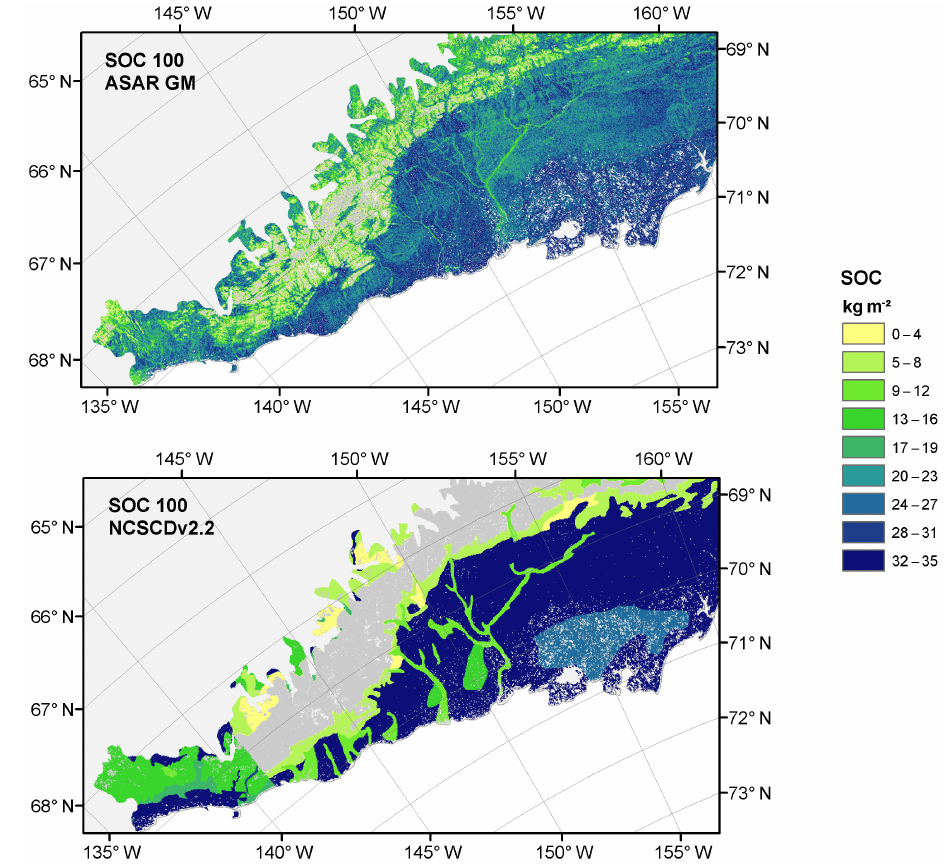
Figure 8. Subset maps (Alaska–Canada border region and parts of the Brooks Range and North Slope) of SOC 0–100cm results from ENVISAT ASAR GM and the NCSCD. For legend, see Fig. 5a; medium-grey values correspond to 0kgm − 2